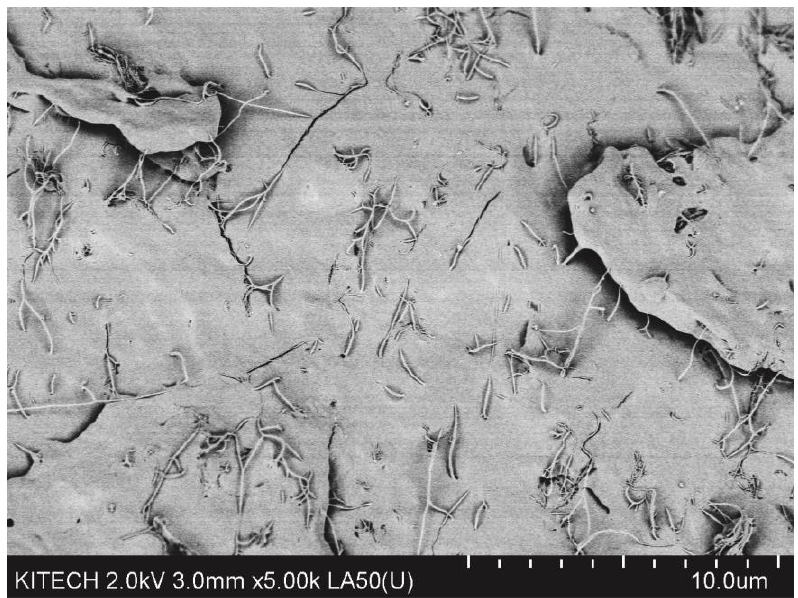
Figure A1. SEM image of the 0.43 wt.% SWNT/PP composite.